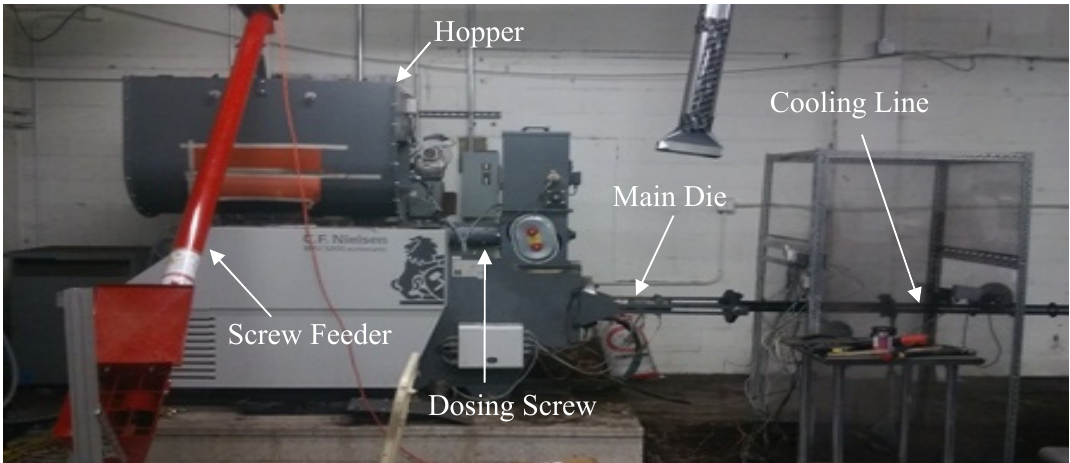
Figure 2. Pilot scale briquette press used in the present study.